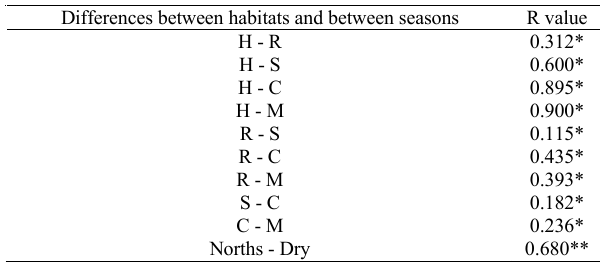
Table 5. R statistics values and their significance levels for pair-wise comparisons of species composition of the habitats and seasons using ANOSIM (p<0.05). hyperhaline: H, rocky: R, seagrass: S, channel: C, marine: M. * p<0.001,**